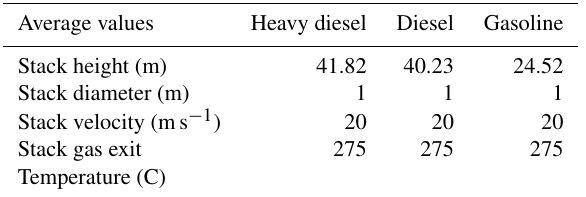
Table 3. Stack parameters for different ship emission inventories used in this